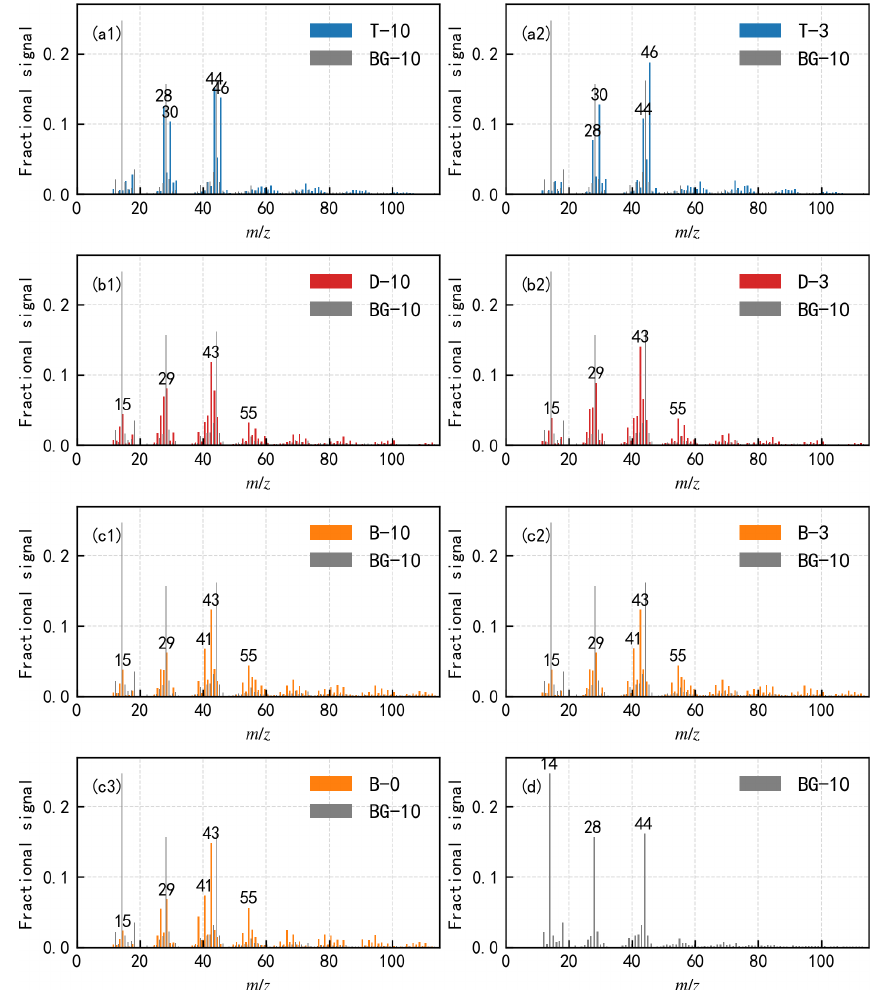
Figure 6. Normalized aerosol mass spectrometer (AMS) mass spectra of COJ300 BC particles coated with (a) toluene SOA, (b) n -dodecane SOA, (c) β -caryophyllene SOA, and (d) bare COJ300 BC particles. More oxidized SOA is generated when toluene acts as a precursor, while less oxidized SOAs are generated when n -dodecane and β -caryophyllene act as precursors in this study, as indicated by the different fractions of m/z = 43 and 44, respectively (Lambe et al., 2011b; Ng et al., 2011; Canagaratna et al., 2015). The absolute organic mass loading present in the bare COJ300 BC experiment is less than 1% of the organic mass loading from the other three types of SOA coating